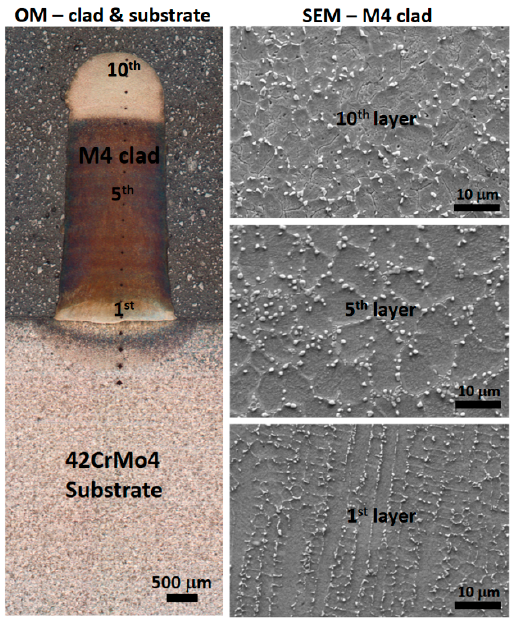
Figure 3. Vertical cross-section observations of the thin-wall sample obtained by optical microscopy (OM) and scanning electron microscopy (SEM).